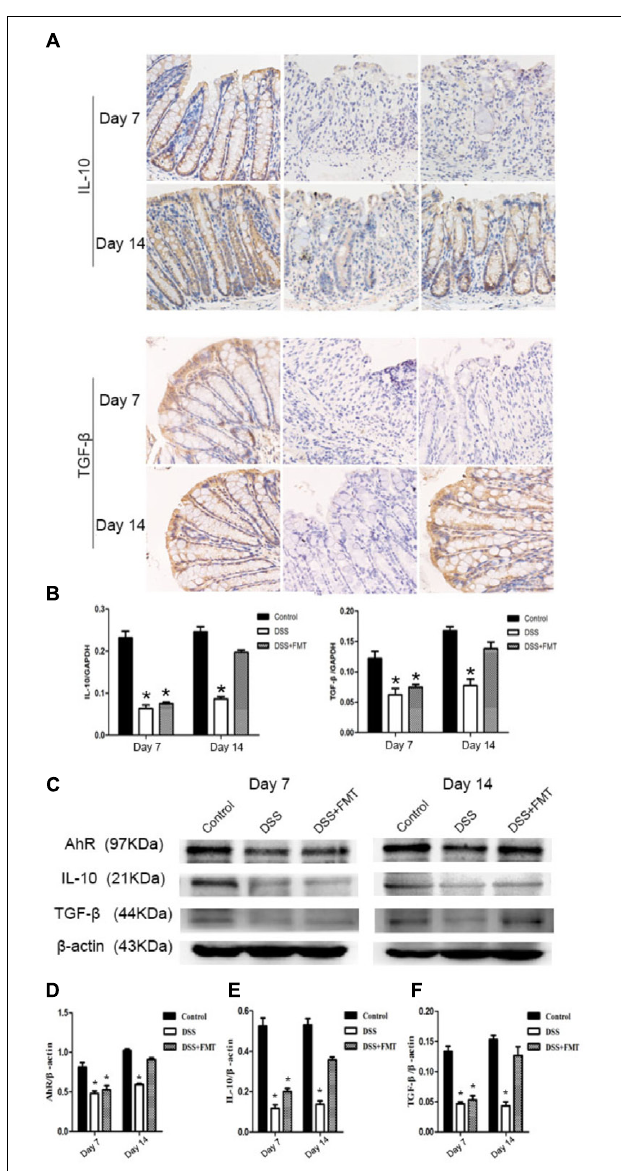
FIGURE 6 | Compared with that in the control group, decreased IL-10 and TGF- β expression in colon tissues of mice was induced by DSS and detected by immunohistochemistry. Representative photographs of immunohistochemical staining of IL-10 and TGF- β at the indicated time point in each group (A) . Scale bars = 50 µ m. (B) The mRNA level of IL-10 and TGF- β in colon tissues of different groups. (C) Protein expression of AhR, IL-10, and TGF- β in colon tissues of different groups. (D) The ratio of AhR/ β -actin in each group. (E) The ratio of IL-10/ β -actin in each group. (F) The ratio of TGF- β / β -actin in each group. ∗ p < 0.05 compared to the control